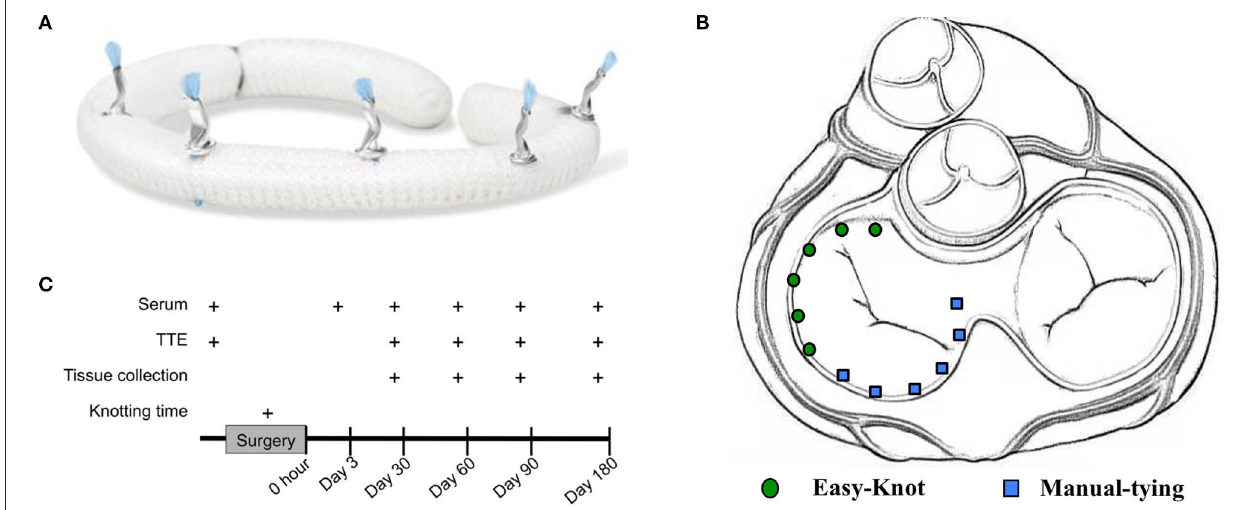
FIGURE 1 | Experimental design and knotting effect of Easy-Knot. (A) Realistic graph of knots on an annuloplasty ring tied by Easy-Knot. (B) Schematic diagram of knotting sites by Easy-Knot (green dot) and manual tying (blue square) for annuloplasty ring fixation. (C) Data acquisition guideline. IntelliVue MP70), body temperature, blood gas (Abbott